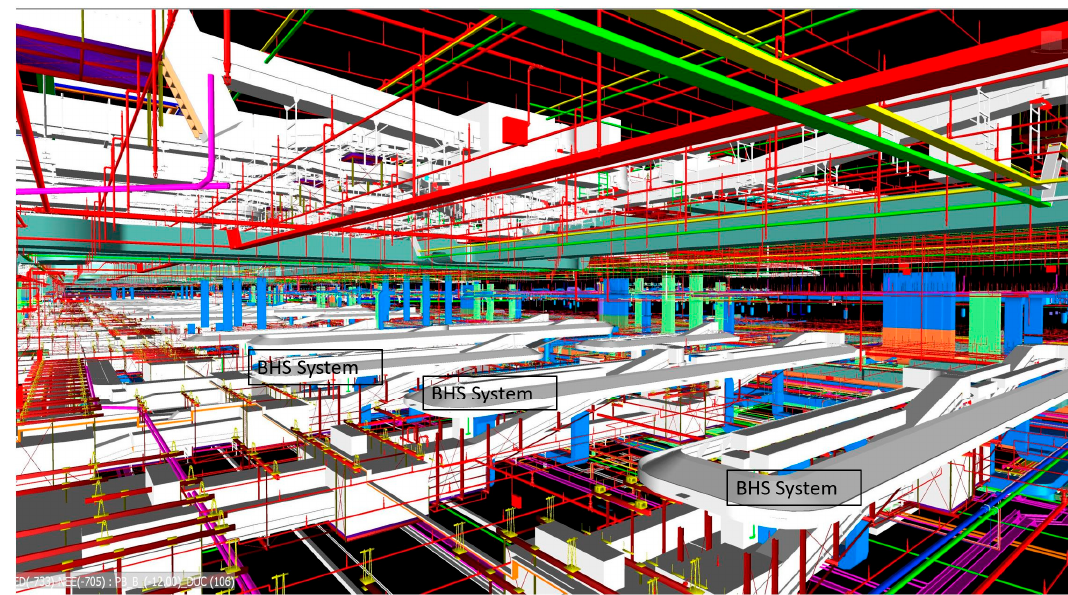
Figure 4. Viewpoint of the cross-coordination of the BHS systems and MEP elements within the Terminal Building Zone. Blue & Green & Orange Ducts: HVAC Ducts, Purple: Waste water discharge line, Red pipes (inside the terminal area): Fire protection, Red trays: Cable trays, Green trays: Low voltage cable trays, Yellow trays: Ultra low voltage cable trays One of the struggling processes was reported as the coordination at knuckle points where terminal and pier buildings are connected. These points are some of the most congested areas in terms of MEP-IT elements. Their clash-free placement, considering the architectural and structural transition of spaces, became significantly challenging both on-site and at the office.